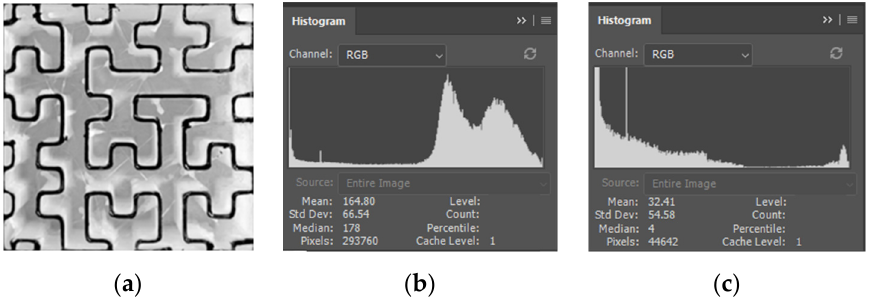
Figure 9. Black and white image of cross-section except for contour ( a ); gray level histogram of the entire filled area ( b ); gray histogram of the black filling curve ( c ). Table 2. Pixel ratio based on the gray histogram.